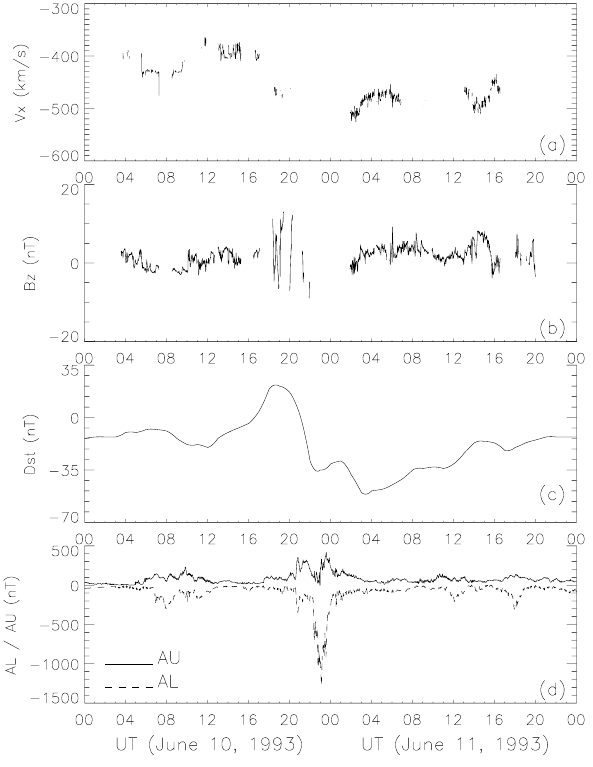
Fig. 1. Variation of the interplanetary parameters and the magnetic indices for the period No 1. From top to bottom: (a) component V x of the solar wind speed, (b) the B z component of the interplanetary magnetic field, (c) the D st index and (d) the AU and AL indices.